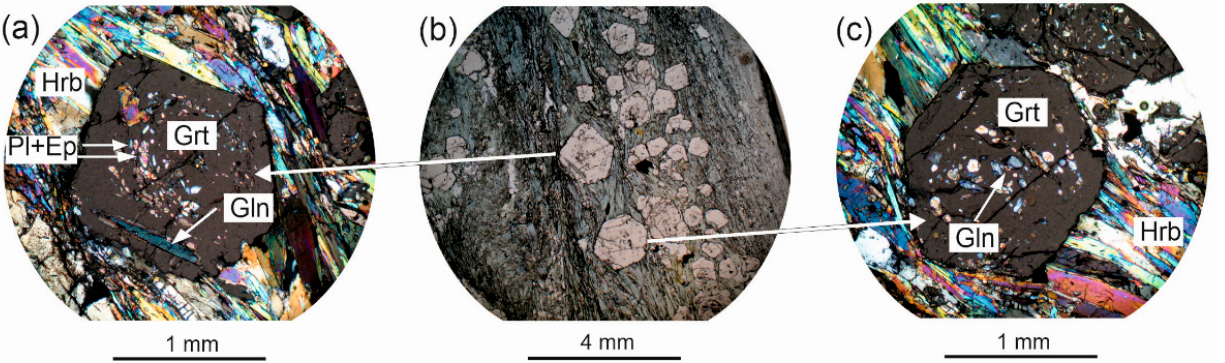
Figure 4. Rock structures and textures of the tectonites of YRSZ indicated by the segregation redistribution of the material under the conditions of the regional shear: ( a , c ) relic inclusions of glaucophane, albite, phengite, and epidote in porphy- roblasts of garnet, crossed nicols; ( b ) late segregation isolations of lenticular-banded morphology are essentially garnet- amphibole aggregates, parallel